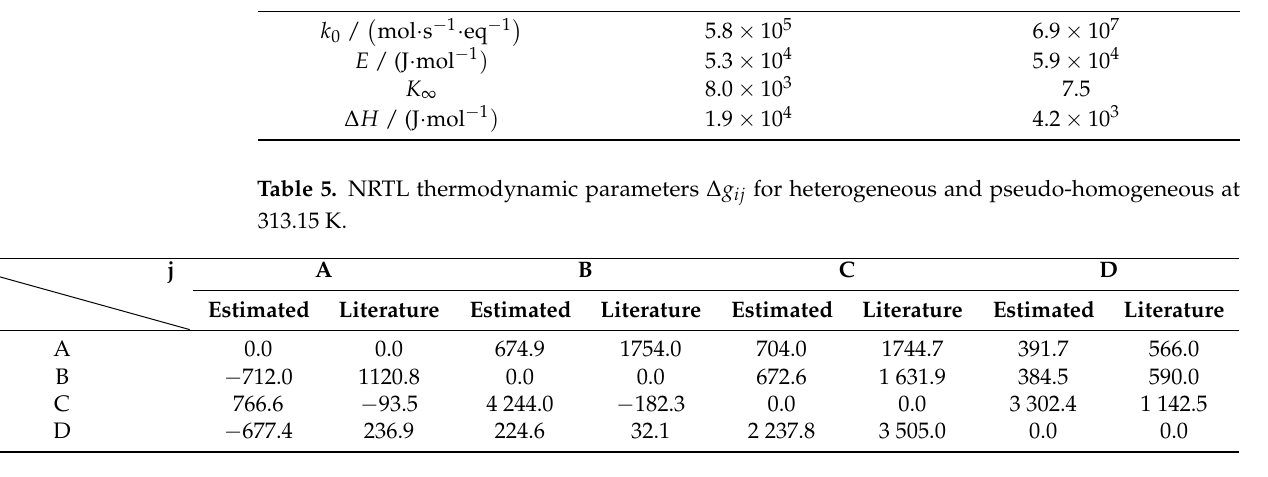
Table 6. RMDS between experimental results and simulations results using the parameters estimated in this work and parameters from